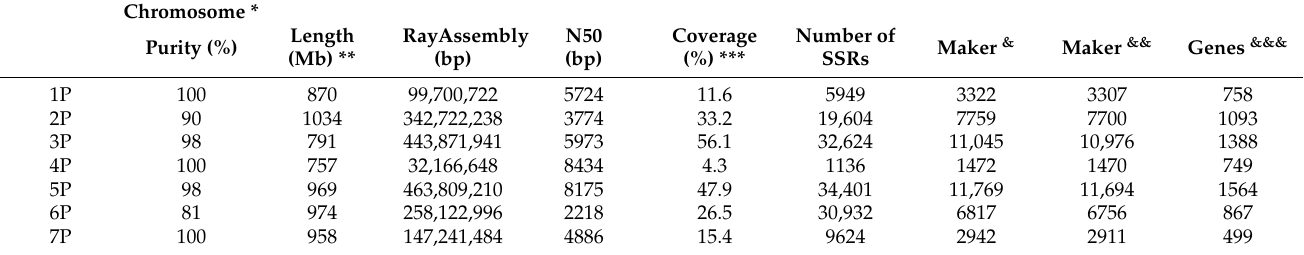
Table 1. Sequencing of A. cristatum